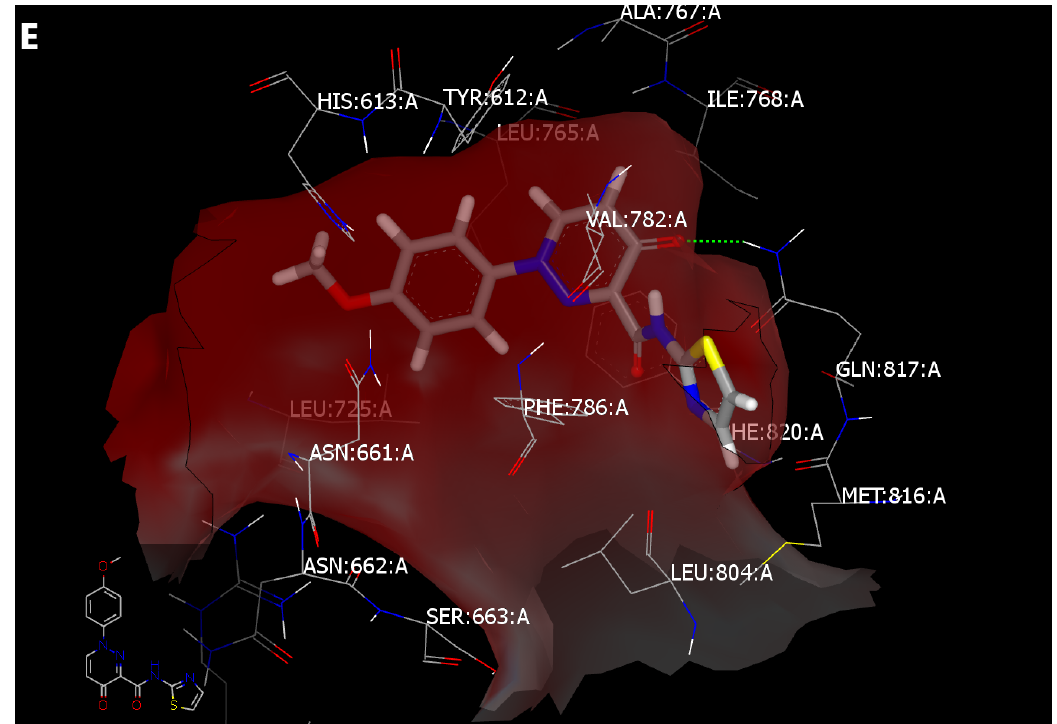
Figure 3. ( A ) Sildenafil docked with PDB ID: 2H42 with formation of two HBs and hydrophobic–hydrophobic interaction; ( B ) overlay of compounds 3 , 7a , 8b , and 11a in the same pane of sildenafil with formation of two HBs with GLN:817:A; ( C ) overlay of compounds 2 , 10a , 11b , c with the formation of one HB with GLN:817:A; ( D ) compound 10a forms two HBs with GLN:817:A and TYR:612:A in addition to hydrophobic–hydrophobic interaction; ( E ) compound 11b forms one HB with GLN:817:A in addition to hydrophobic–hydrophobic interaction.